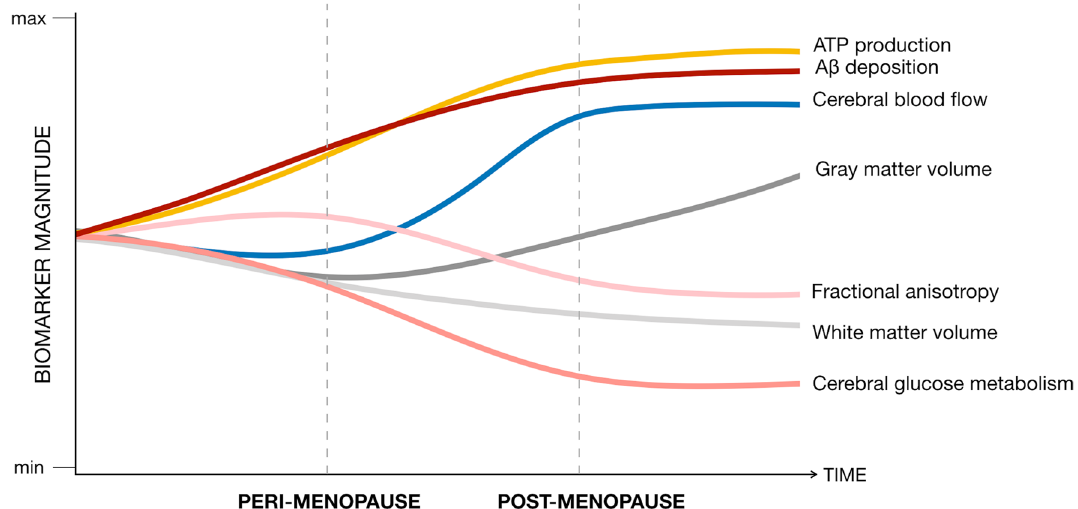
Figure 5. Summary of brain biomarker effects during the menopause transition. This figure summarizes the main results of the study by mapping estimated brain biomarker outcomes from pre-menopausal to peri- menopausal and post-menopausal stages. Biomarker measures extracted from representative clusters for each modality are displayed on a standardized scale and normalized to pre-menopausal levels to enable examination of the magnitude of biomarker effects by menopausal stage and across